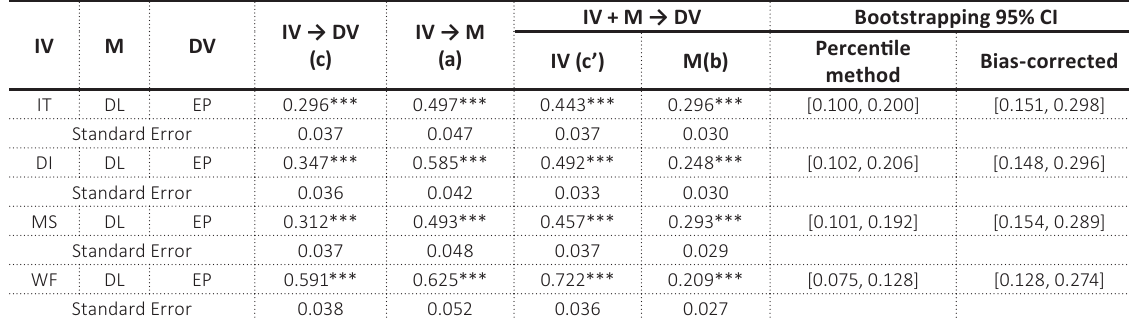
Table 5. Mediation